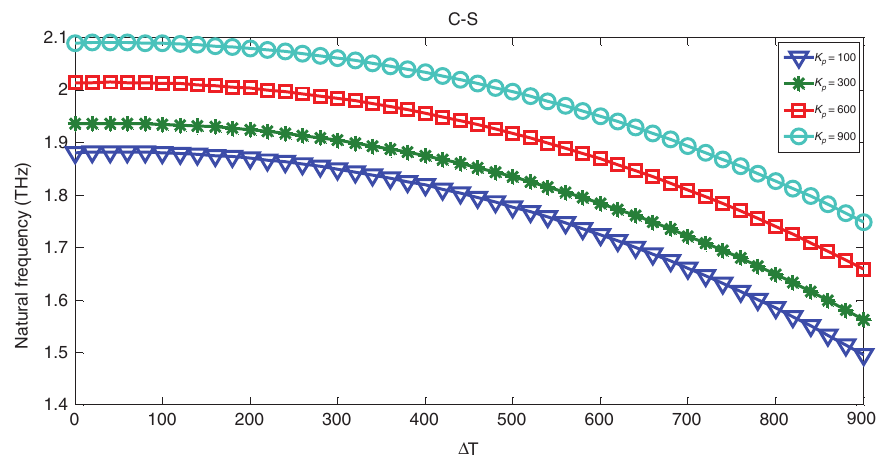
Figure 10: The effect of Pasternak stiffness on the natural frequency with clamped-simply boundary condition.